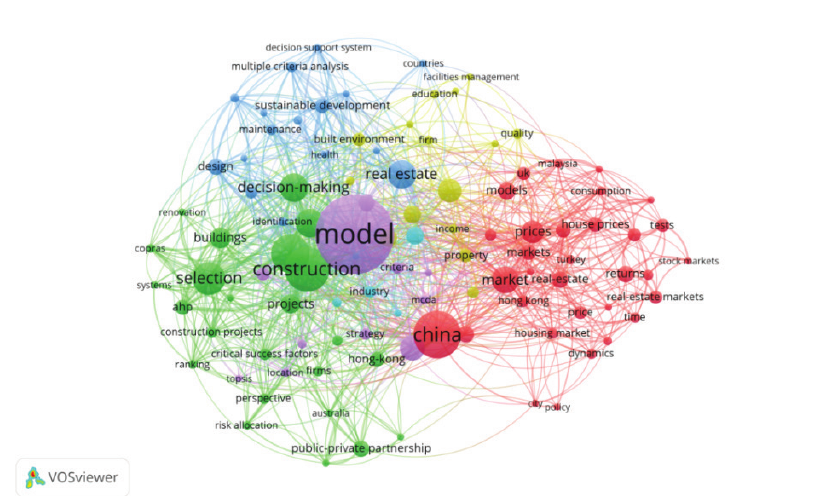
Figure 11. All keyword co-occurrence network of the IJSPM publications